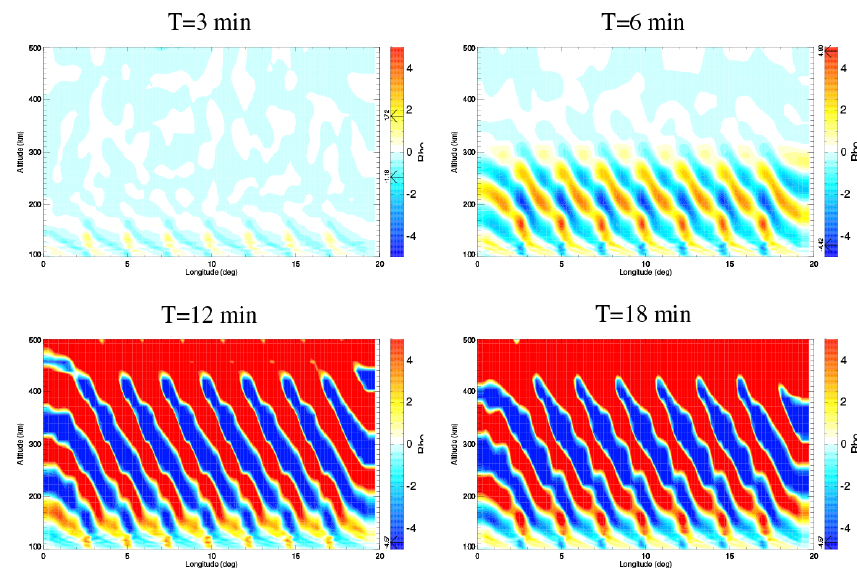
Fig. 4. The same as Fig. 2, but for the low-frequency wave ( ω = 0 . 25 ω B , λ = 4 πH